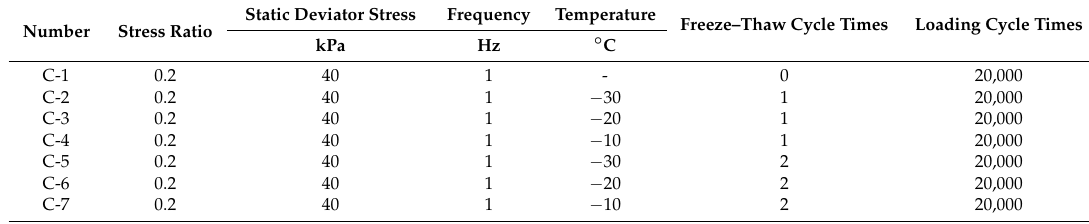
Table 1. GDS experimental